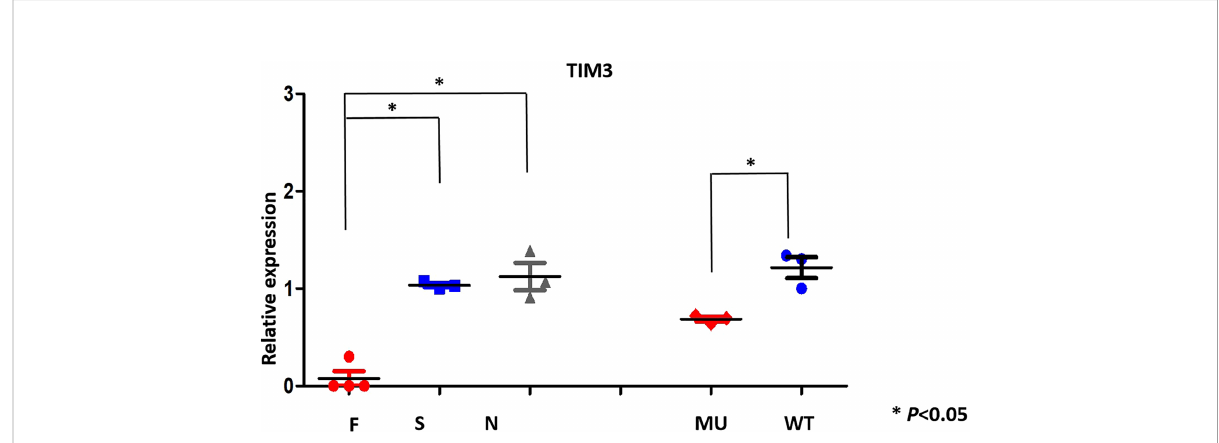
FIGURE 3 TIM-3 mRNA expression pattern (qRT-PCR) in family members(F) and proband; sporadic T -cell lymphoma(S), normal individuals(N) and transfected HEK293